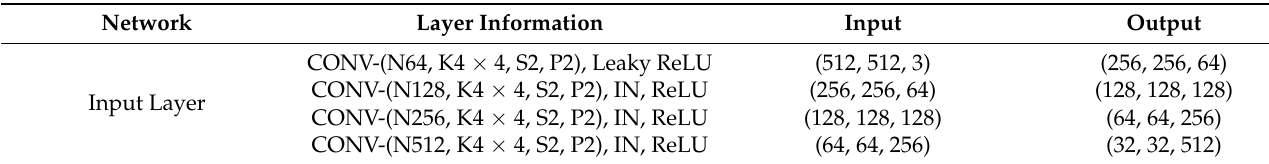
Table 2. The architecture of the